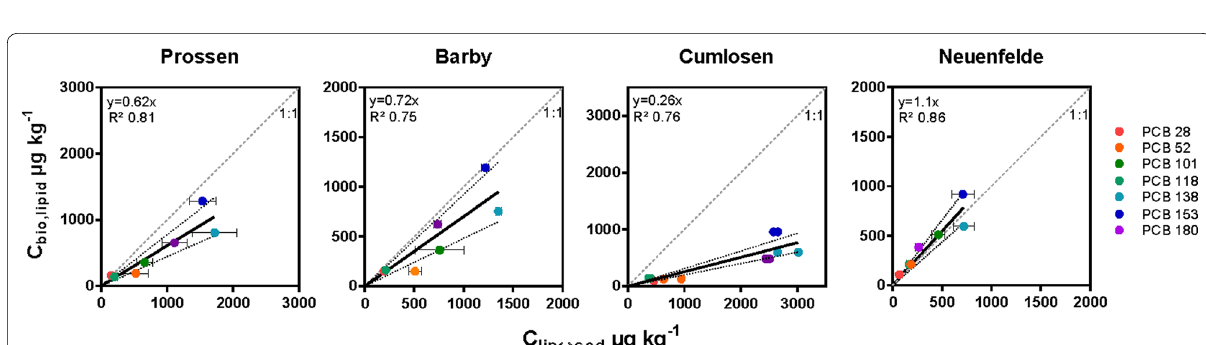
Fig. 6 Lipid normalised concentrations of PCBs in muscle tissue of Abramis brama ( C bio,lipid in µg kg − 1 lipid) plotted over equilibrium concentrations ( C lip in µg kg − 1 lipid) for the stations Prossen (km 13), Barby (km 296), Cumlosen (km 470) and Neuenfelde (km 636). The limit of detection (LOD) ↔ sed was 3.3 µg kg − 1 wet weight and for Barby PCB 28 and PCB 52 and for Cumlosen PCB 28 were exactly on this LOD. C lip ( n 3) and error bars are standard deviations. For Cumlosen only two replicates are available of which both are presented. C bio,lipid values are single = measurements. Dashed lines represent 1:1 relationship and dotted lines are confidence intervals of the linear regression forced through the